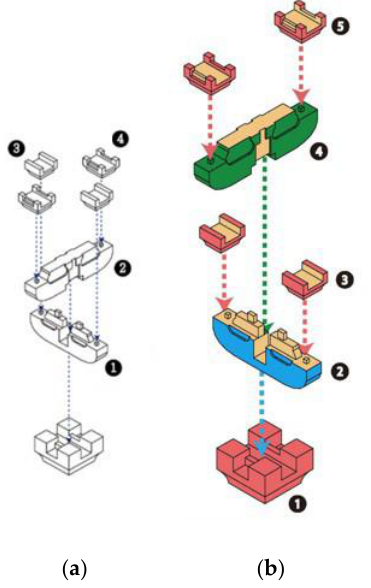
Figure 3. Improved paper-based assembly instructions: (a) original form and (b) improved version.